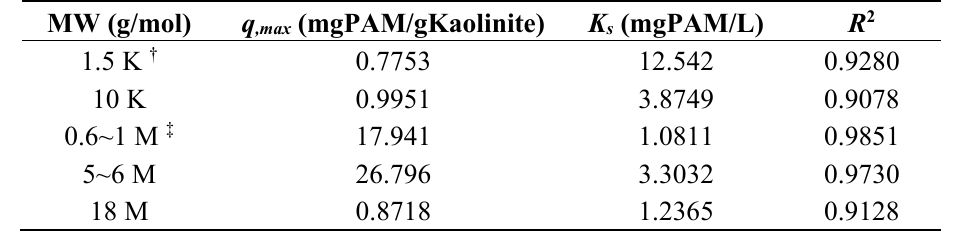
Table 1. Results of nonlinear data fitting to Langmuir isotherms ( q e = q max × C e /( K s + C e